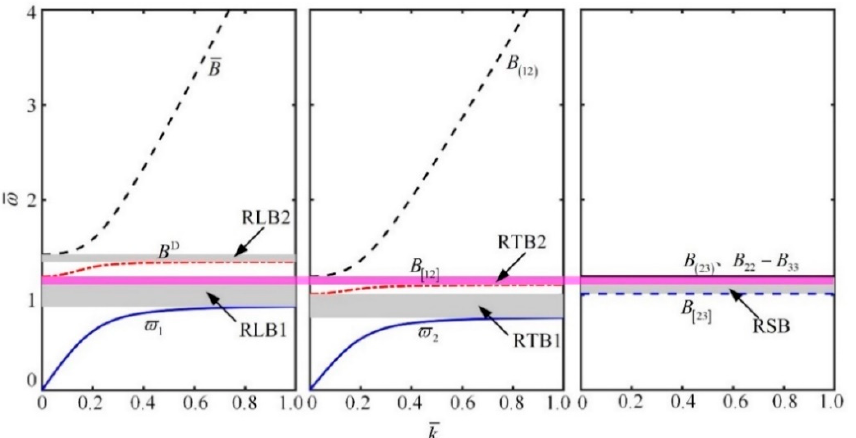
Figure 4. Frequency bandgap between the particle rotation waves: longitudinal waves ( left ), trans- verse waves ( middle ), and in-plane shear waves ( right ).